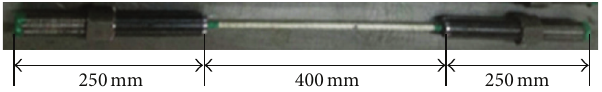
Figure 4: Geometry of tensile test grip and test specimens.